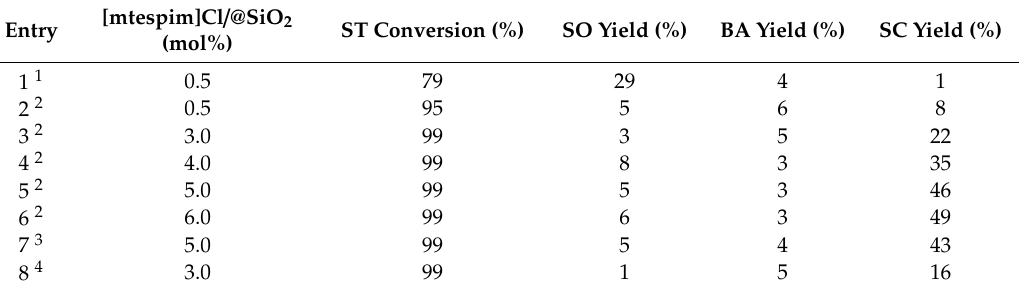
Table 5. Synthesis of styrene carbonate from CO 2 and